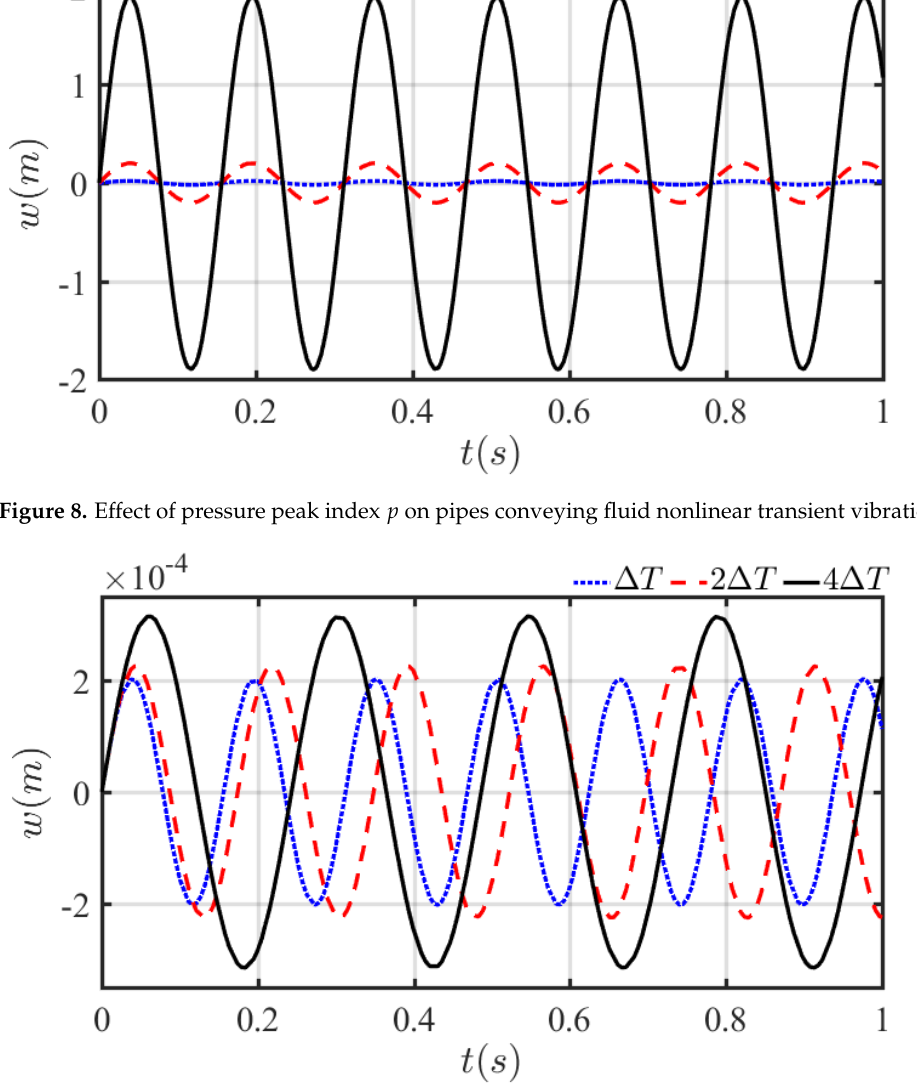
Figure 9. Effect of temperature differences on pipes conveying fluid nonlinear transient vibration.